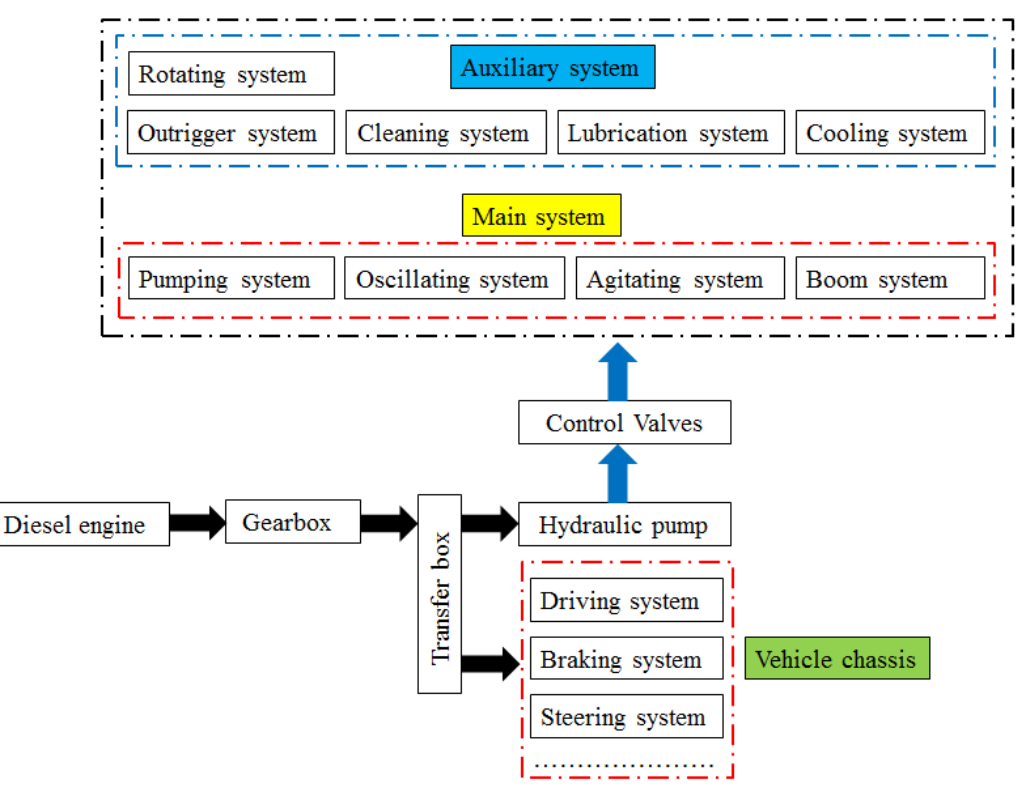
Figure 5. Structure diagram of truck-mounted concrete pump.